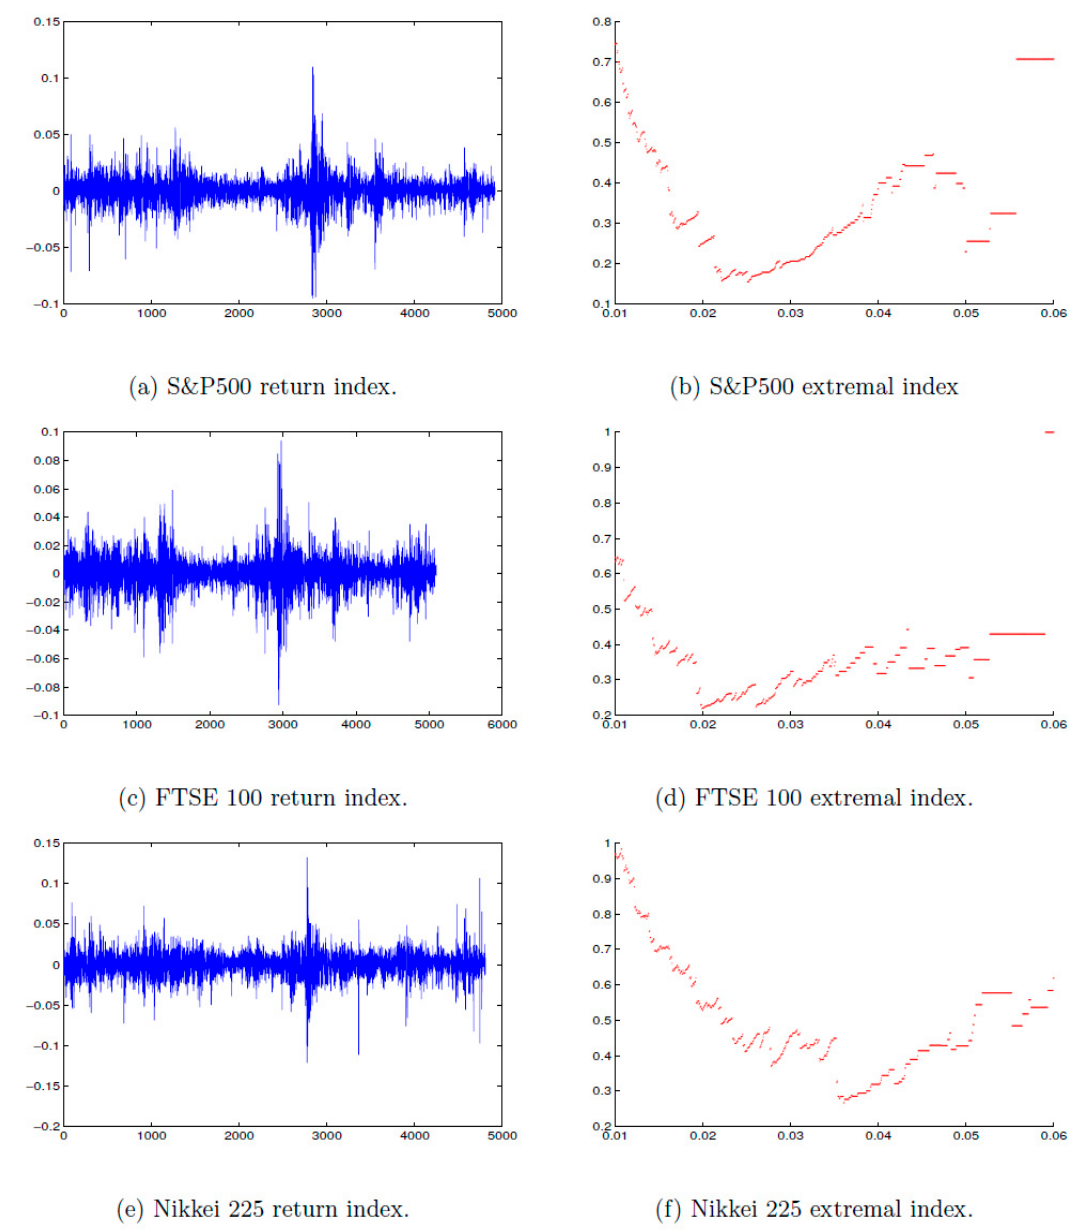
Figure 1. Daily log returns of ( a ) S&P 500, ( c ) FTSE 100, ( e ) Nikkei 225 for the period from 1 July 1997 to 16 January 2017, that consists of an average of ( n = 5000) observations. The estimated extremal index of ( b ) S&P 500, ( d ) FTSE 100, ( f ) Nikkei 225 at a range of threshold u.